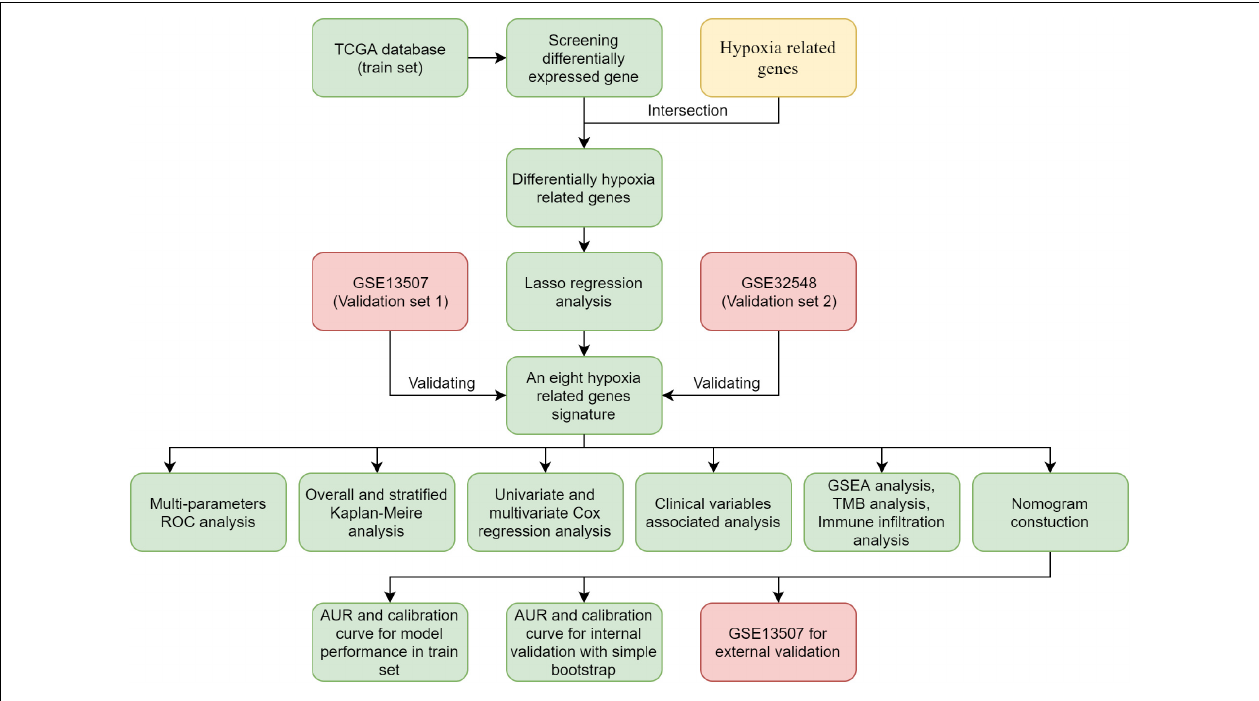
FIGURE 1 | Flowchart of the